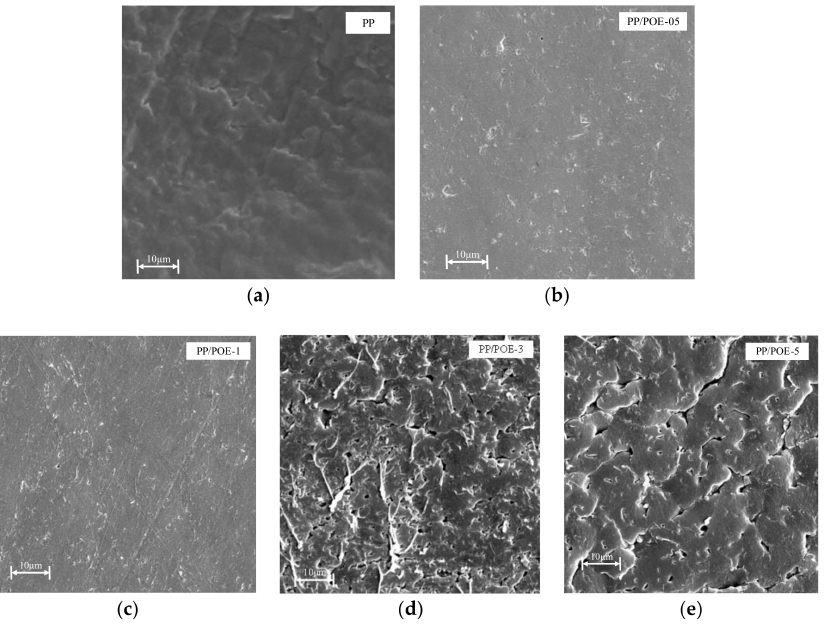
Figure 1. Dispersion of POE in the PP matrix. The micro cracks at surface were POE that were dissolved by heptane, and the size of the crack increased with the POE content: ( a ) PP; ( b ) PP/POE-05,